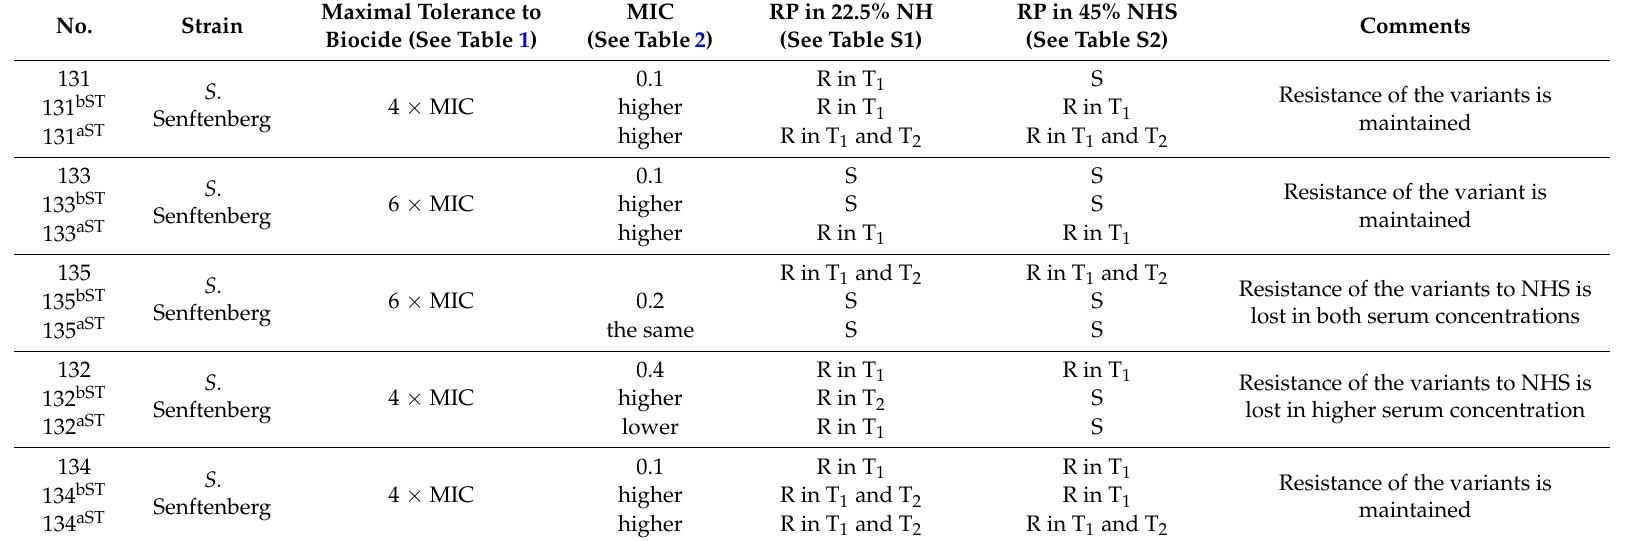
Table 4. Collective phenotypic characteristic of the tested Salmonella Senftenberg strains and their biocide-tolerant variants. Maximal Tolerance to No. Strain